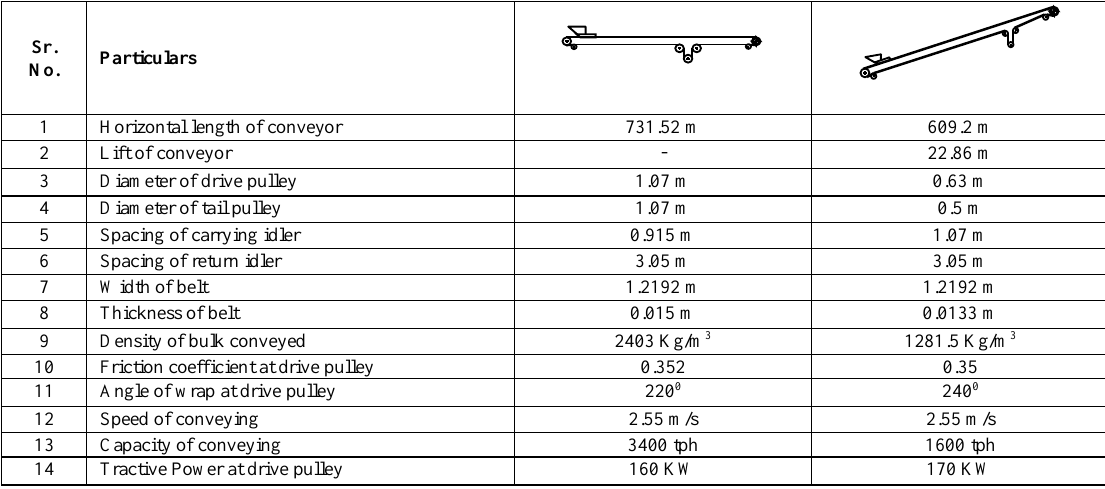
Table 1. Specifications of belt conveyor